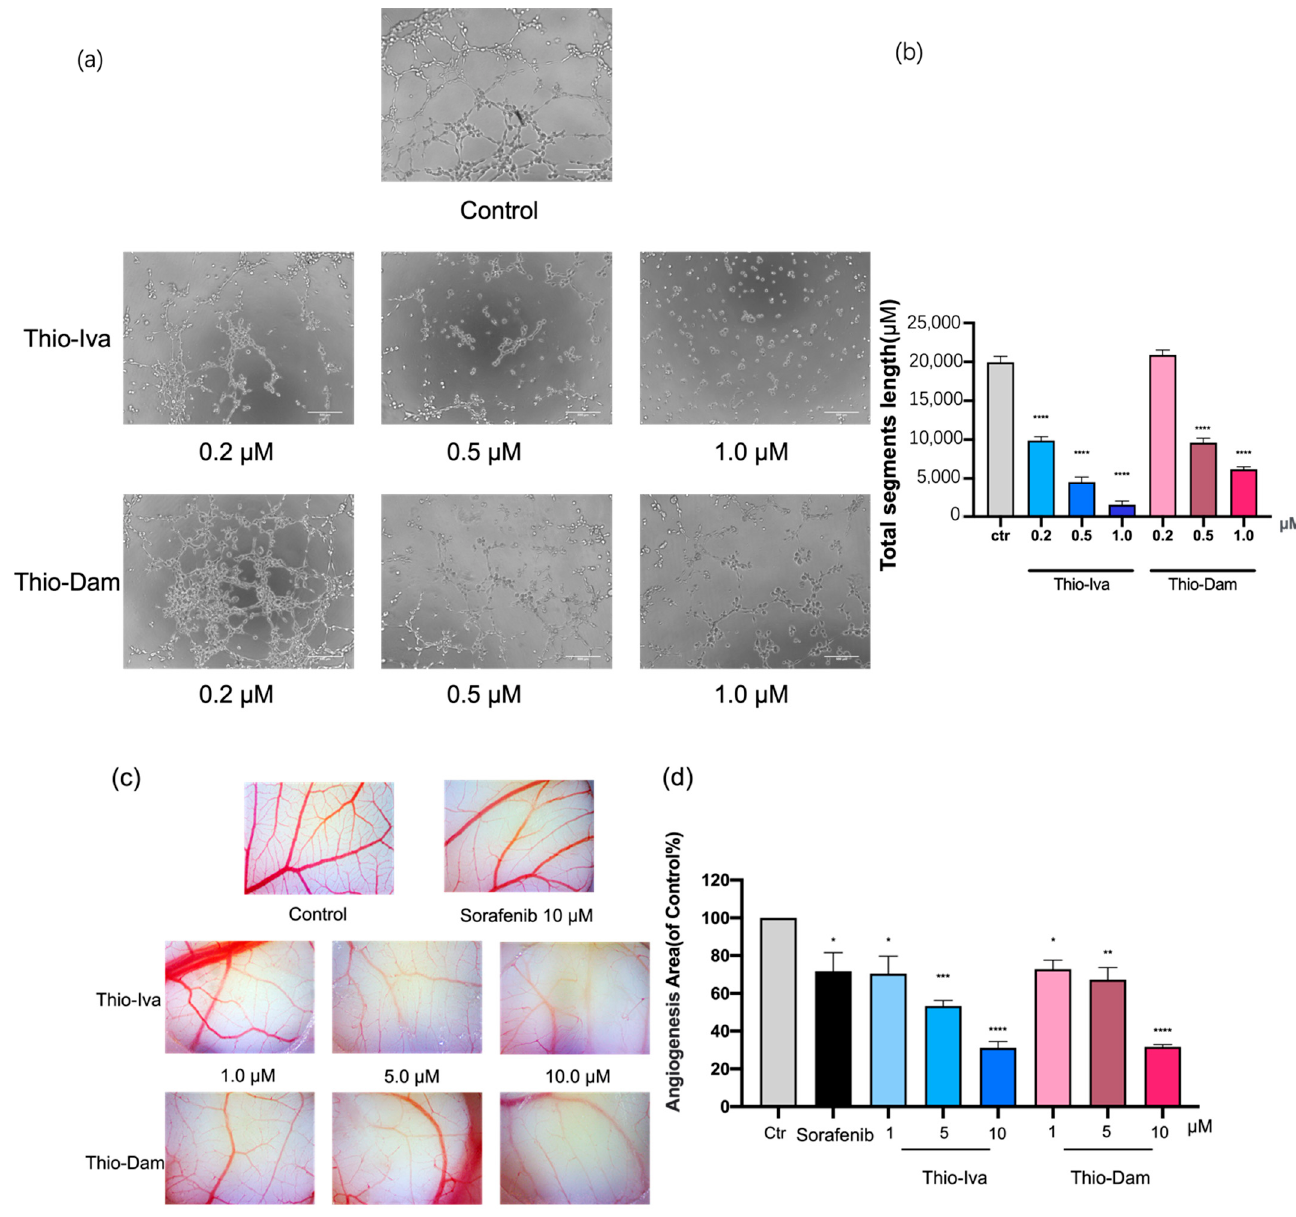
Figure 9. In vitro and in vivo effects of Thio-Iva and Thio-Dam on angiogenesis. ( a ) Representative images of tube formation assay with EA.hy926 cells. Thio-Iva and Thio-Dam (0.2–1 μ M) were applied for 6 h. ( b ) Tube formation of EA.hy926 cells was quantified and depicted as changes in total segment length using ImageJ software. ( c ) CAM assay showing inhibition of angiogenesis in vivo: Representative examples of CAM were taken from a typical experiment. Untreated control is the area outside the silica ring. Inside the silicone ring, the surface was treated with different concentrations of Thio-Iva and Thio-Dam for 48 h. ( d ) Image-Pro Plus software was used in analysis for blood vessel area quantification (compared to control in %). * p < 0.05, ** p < 0.01, *** p < 0.001, and **** p < 0.0001 by ordinary one-way ANOVA compared to control (untreated area). Results are given as means ± SEM of = 3 independent experiments.